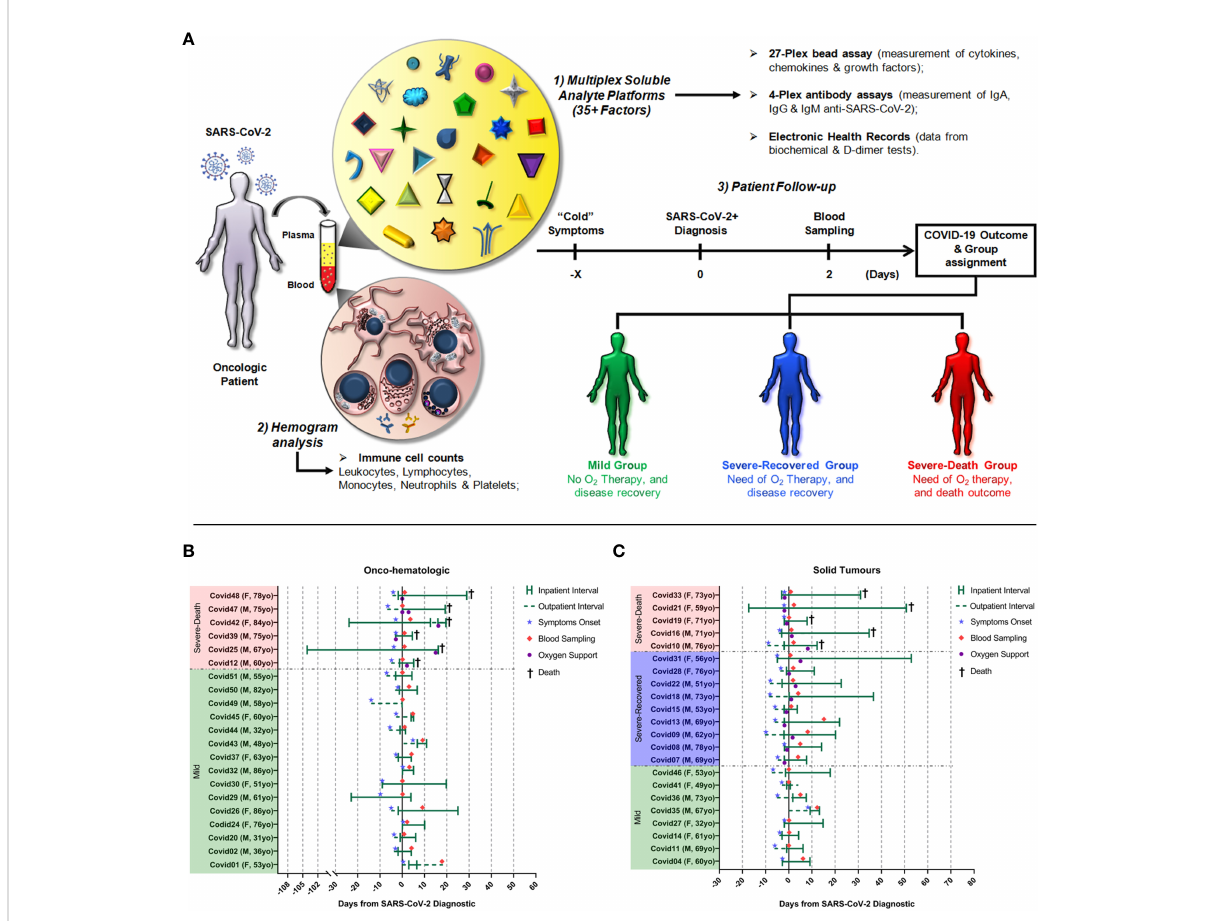
FIGURE 1 Experimental design, cohort clinical characteristics and timeframe of sampling utilized in the study. The fi rst illustration (A) represents the experimental design of this study. Brie fl y, oncologic patients from A.C.Camargo Cancer Center that had a positive diagnostic of SARS-CoV-2 infection were invited to participate in the study. Blood samples were drawn at a median of two days after the con fi rmed diagnostic and analyzed for the concentrations of soluble factors and cell counts. Then each patient was followed-up and assigned to a group based on the need of supplemental O 2 therapy and outcome of COVID-19. Below, the illustration represents the timeframe of hospitalization, symptoms onset, blood sampling and clinical complications (need of oxygen supplementation and death) observed in hematologic cancer (B) or solid tumor (C) patients. Time zero was de fi ned as the day of the positive SARS-CoV-2 qPCR positive